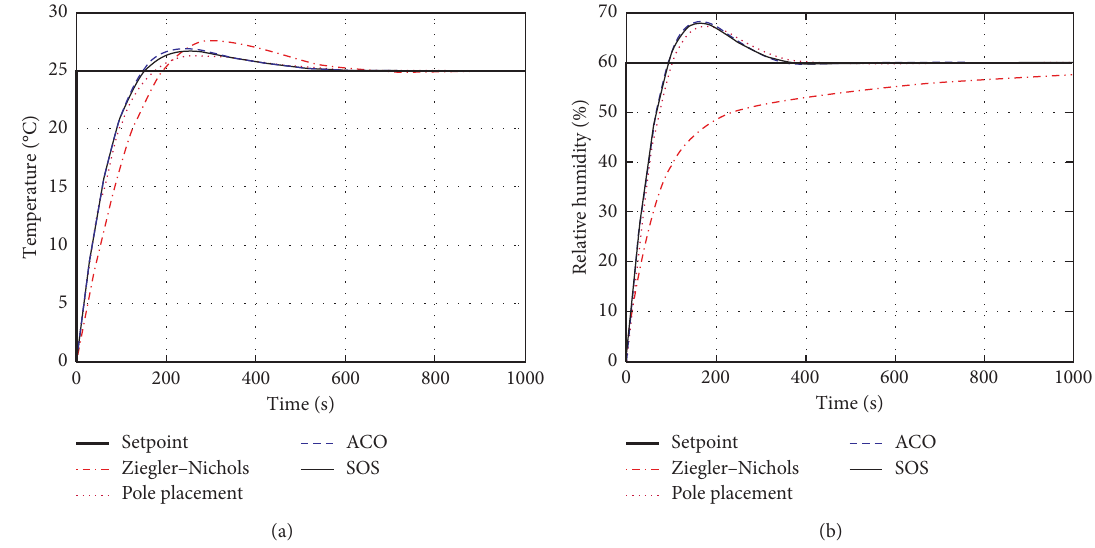
Figure 13: Simulation closed-loop control. (a) Temperature ( ° C). (b) RH (%).